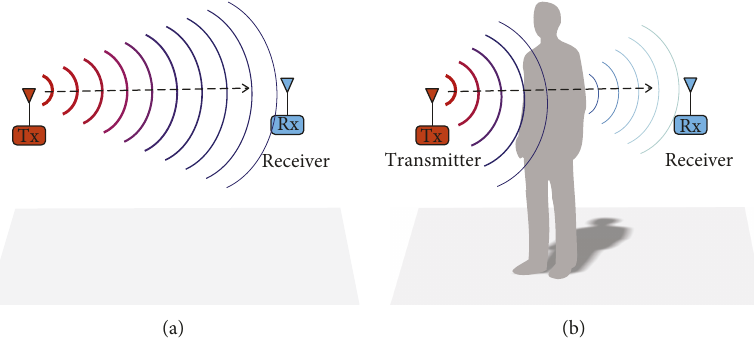
Figure 1: Body shadowing e ff ect: (a) Line-of-Sight case; (b) body shadowing case.